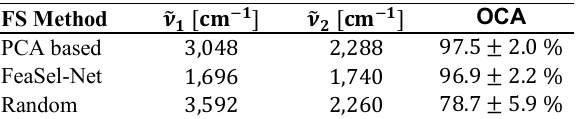
Table 1. Relevant biomarkers and the OCA for both methods.